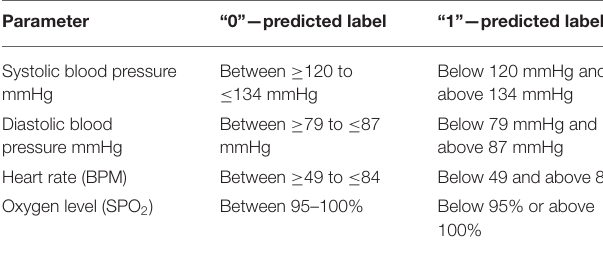
TABLE 3 | Labeled target